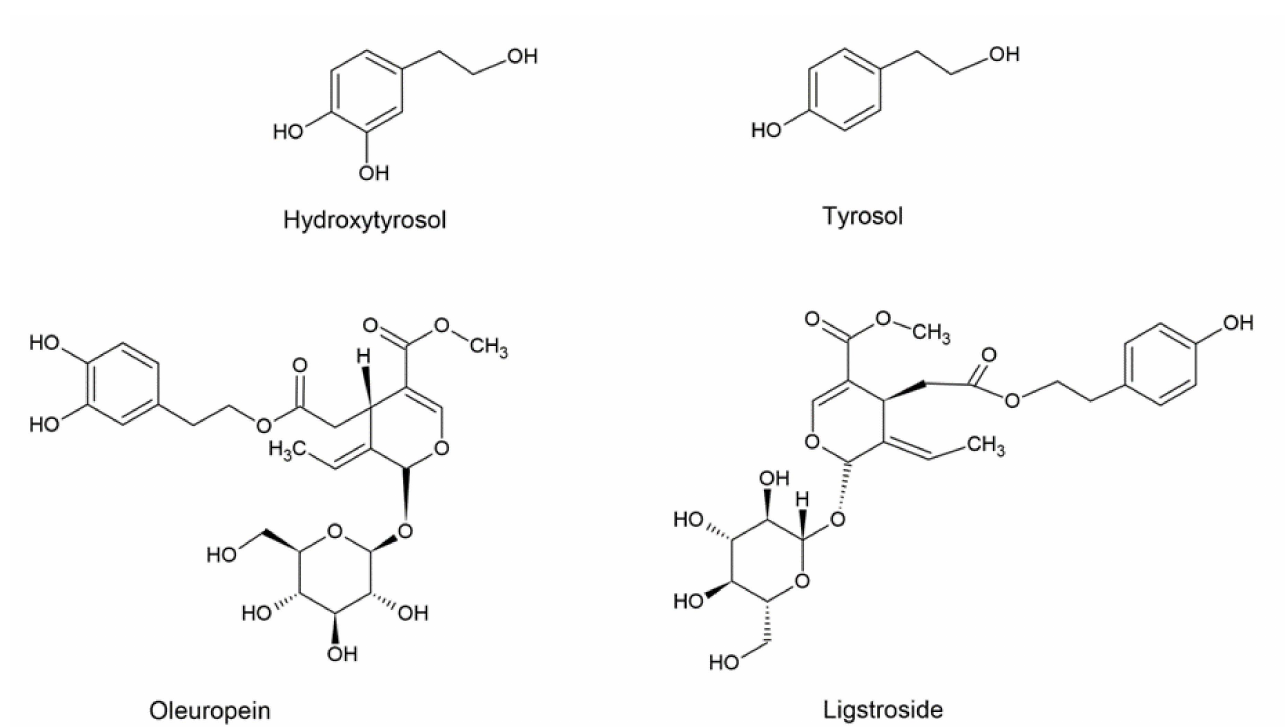
Figure 3. Chemical structures of the main phenolic compounds in olive